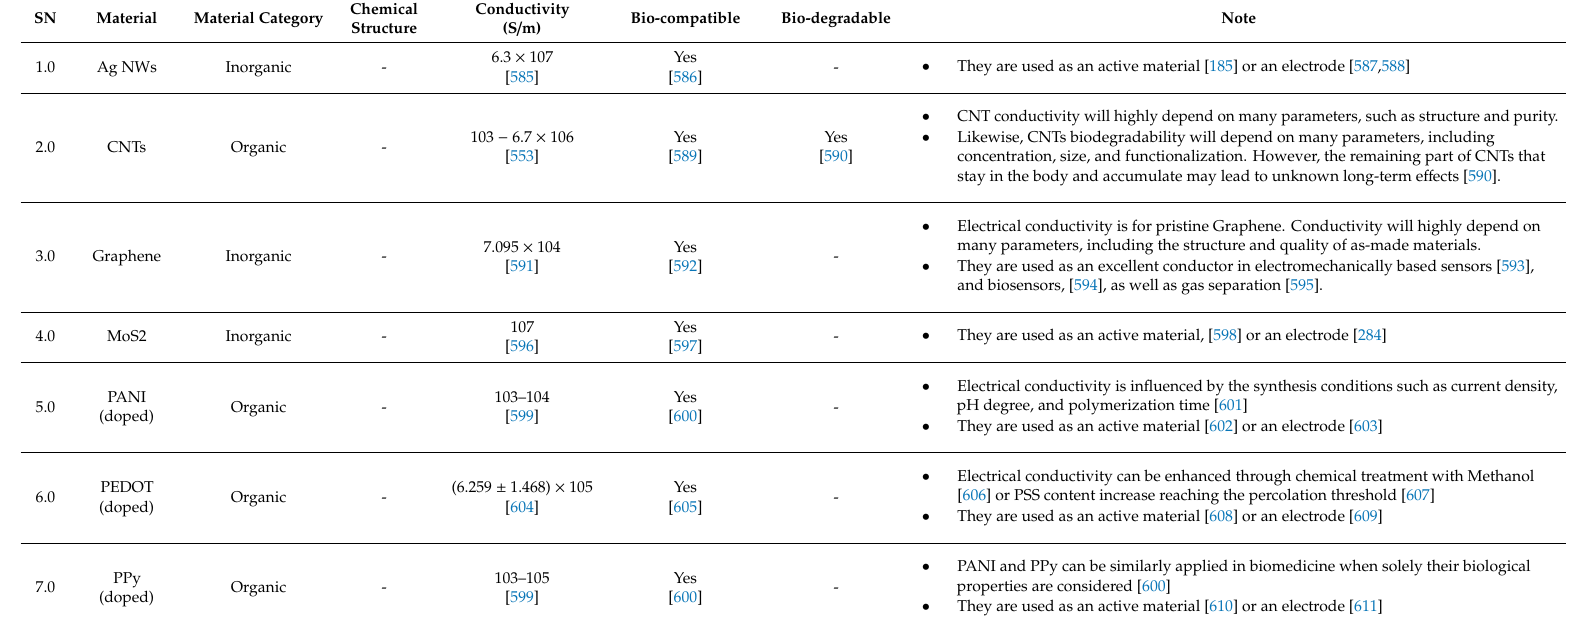
Table 7. List of biocompatible and / or biodegradable materials used in wearable sensors as